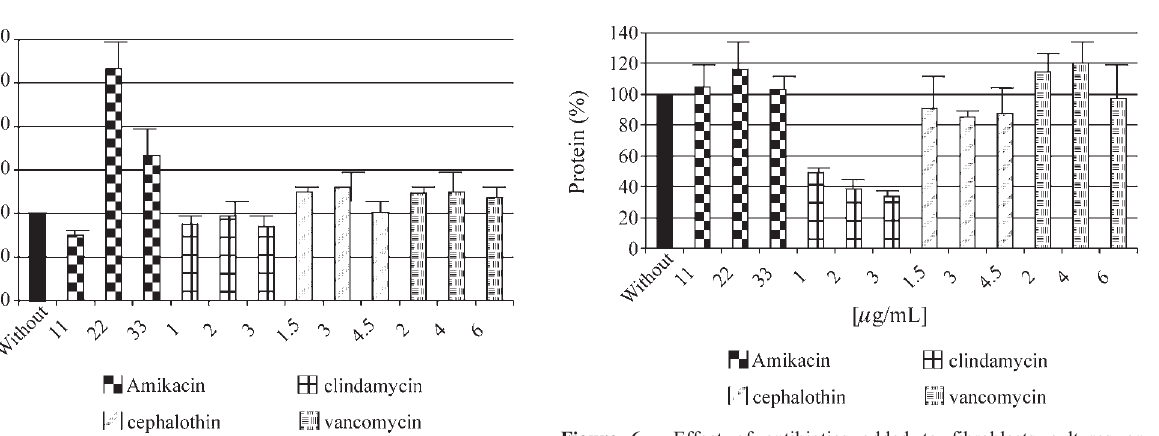
Figure 6 - Effect of antibiotics added to fibroblasts cultures on glucocerebrosidaseactivity.Theresults(mean±SD)areexpressedas%of enzyme activity of cells that received antibiotics in relation to those with- out this drug (100%). * statistical difference from 100%, p <